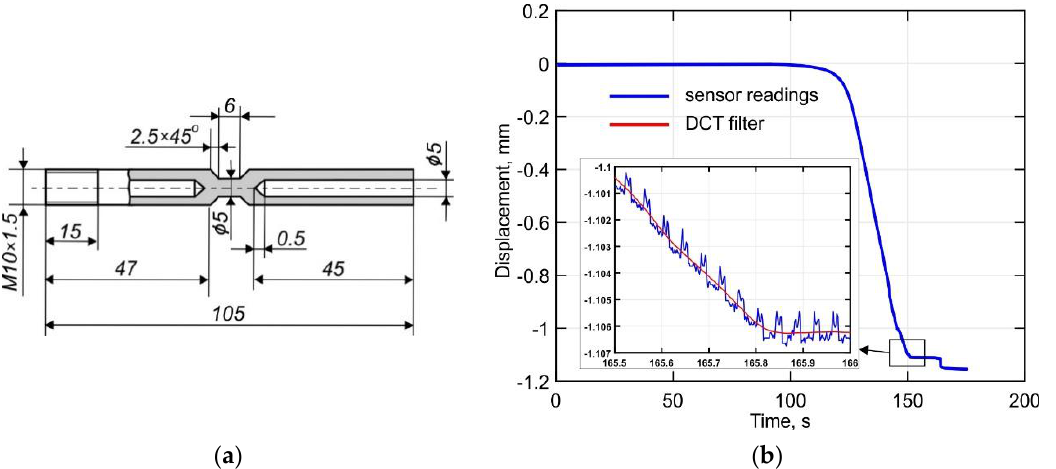
Figure 3. ( a ) A schematic of the Gleeble 3800 test specimen and ( b ) an example of experimental data processing using the DCT filter.